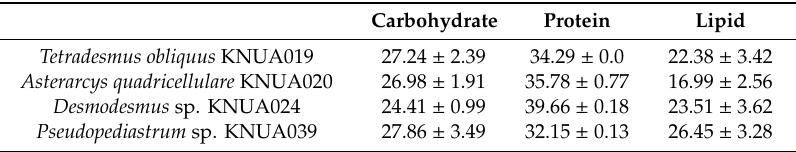
Table 2. Biochemical composition (percent of total weight) of microalgal biomass in treated, primary settled wastewater.